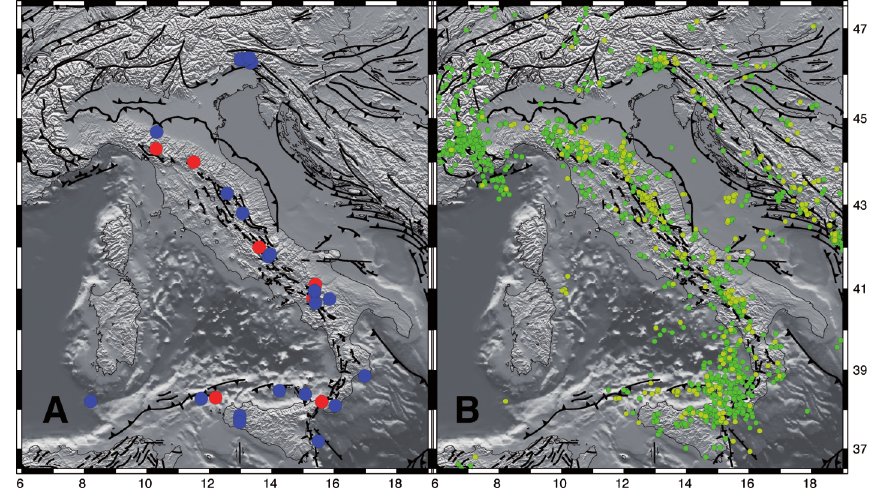
Fig. 2. Maps showing the growing number of earthquakes used as information to study strain and stress fields over the last 30 years. A) red: data from Jackson and McKenzie (1988); blue: data added by Pondrelli et al. (1995) and Pondrelli (1999). B) yellow: data from CMT and RCMT catalogues; green: data coming from the EMMA Database 2.0 (Vannucci and Gasperini,